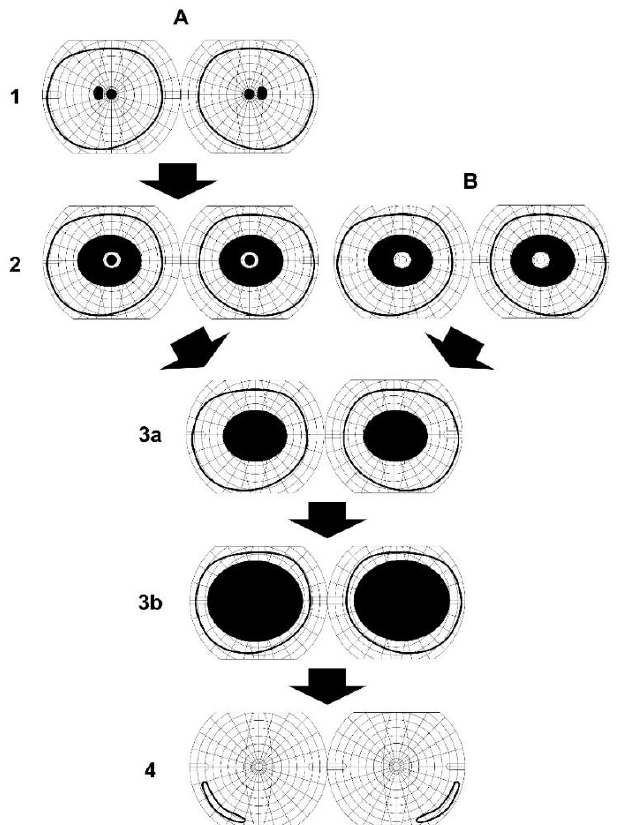
Figure 7. Schematic progression of the visual field defects in patients with DRAM2 -associated retinopathy. A central scotoma appears initially ( A1 ) followed by large ring scotoma ( A2 ). They combine resulting in a large central scotoma (3a,3b). Ring scotoma may appear initially ( B2 ). The residual central vision will be lost resulting in a large central scotoma (3a,3b). Both types A and B have poor visual outcome